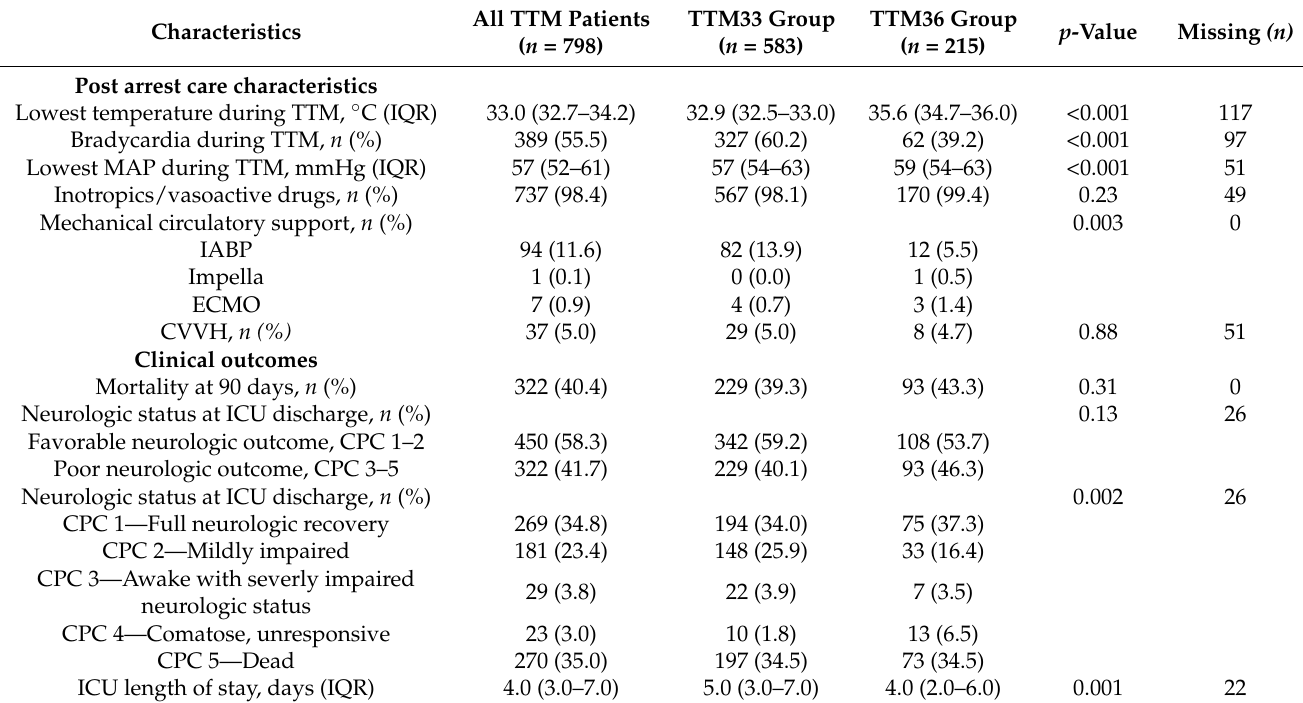
Table 2. Post arrest care characteristics and clinical outcomes in OHCA patients admitted to the ICU.